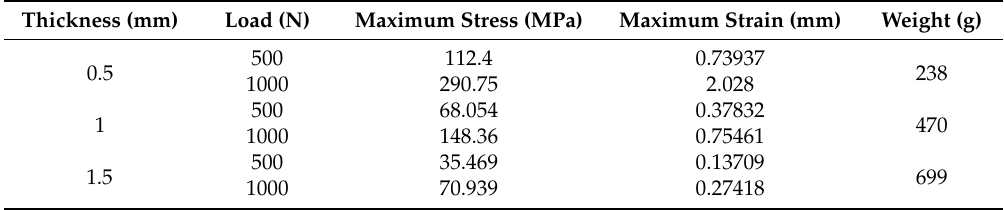
Table 1. Analysis result of thin-wall parts with different thicknesses and loads.